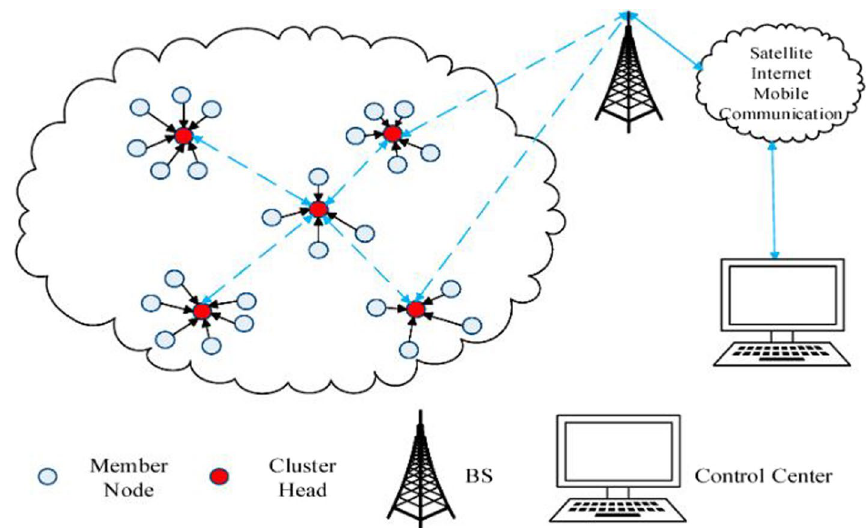
Fig. 4 A typical wireless sensor network (WSN) logical hierarchy diagram